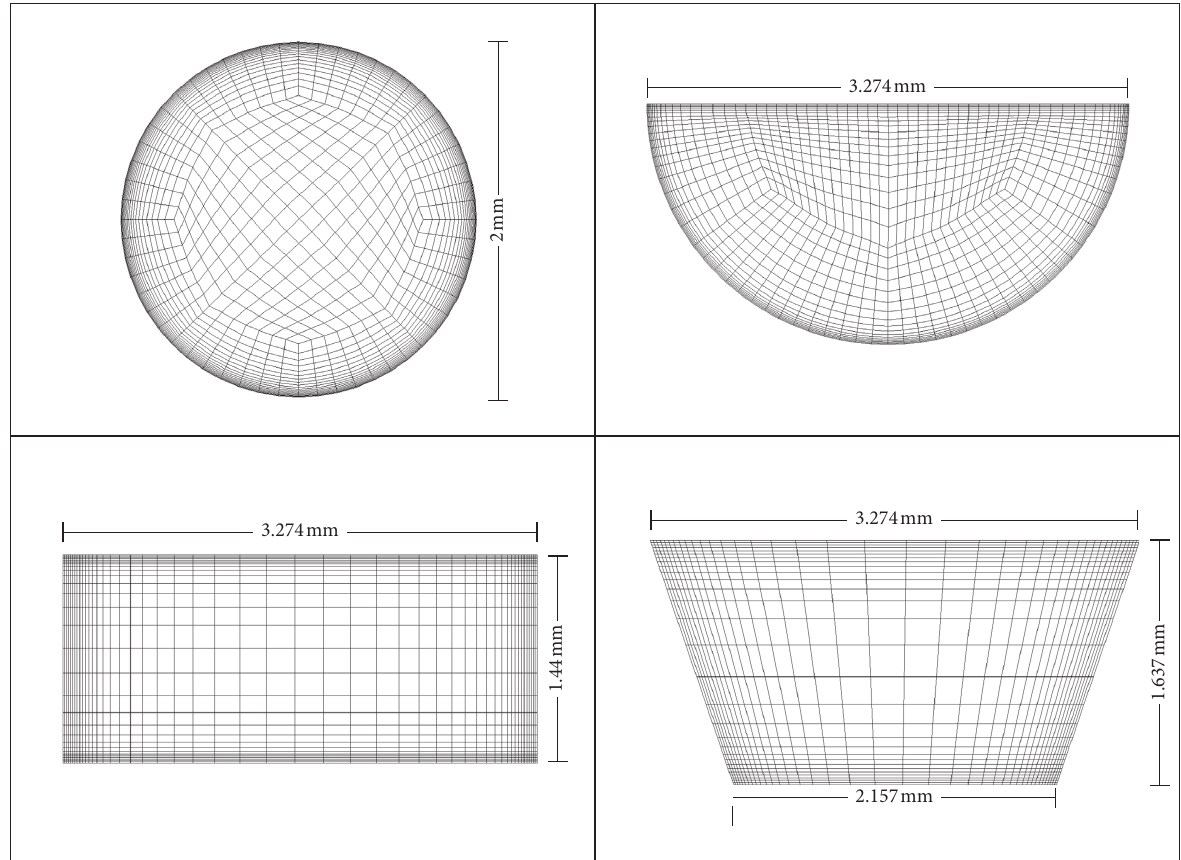
Figure 2: Mesh model and geometric size of the cross